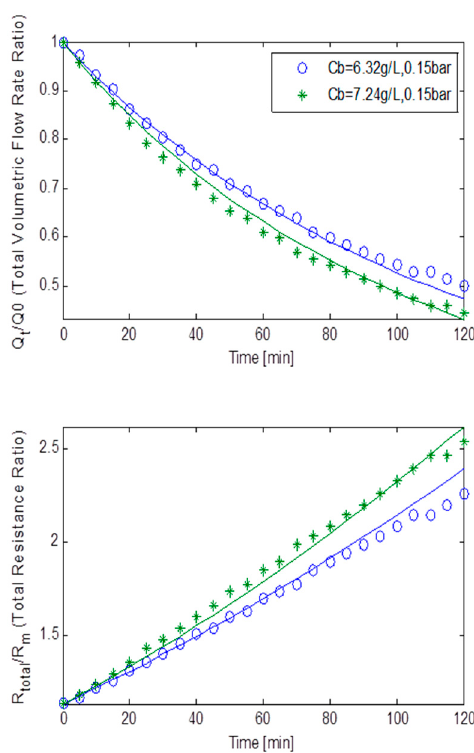
Figure 9. Flux decline and total resistance for TMP step of 15 kPa for the static square-shaped MBR system with best model fits.